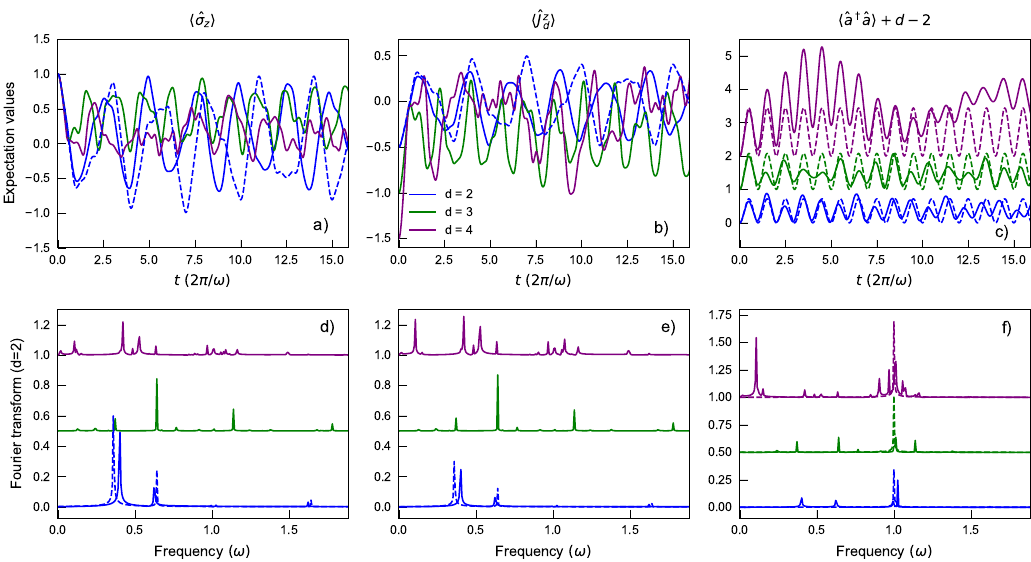
Figure 6: Operator dynamics after quenching the interaction strength. a)-b)-c) Dy- namics of the expectation value of a) the qubit population, b) qudit population and c) mean photon number. The dashed lines in panel a)-c) are given by Eqs. (19),(20). d)-e)-f) Fast Fourier transform of the expectation value evolution for d) qubit popula- tion, e) qudit population, f) photon number population. The curves are vertically off- set by ( d − 2 ) / 2 for visualization purposes. Parameters are Ω = g = 0.3 ω and g 1 2